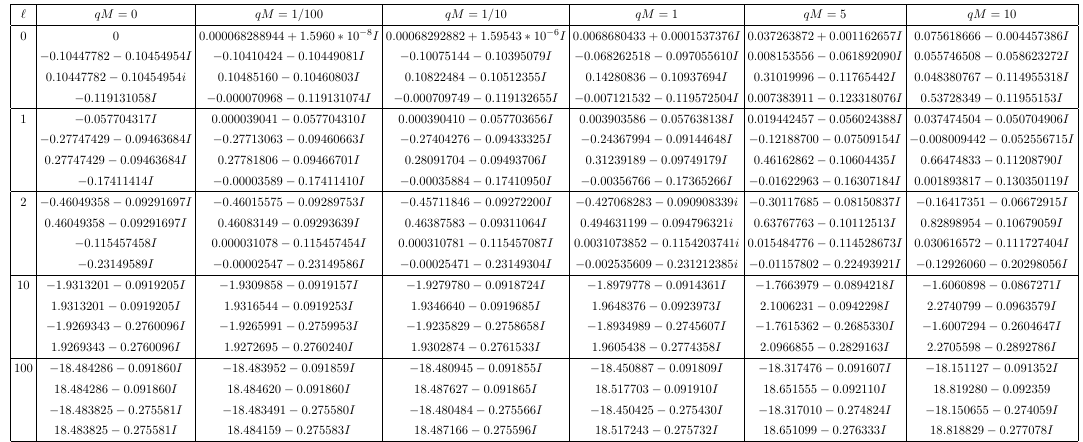
Figure 3 . The effective potential V eff M 2 as a function of r/M , for uncharged scalar fields with ‘ = 0 (left panel), ‘ = 1 (center panel), and ‘ = 100 (right panel) with Λ M 2 = 0 . 04 , and Q/M = 1 / 10 . Here r H /M ≈ 2 . 123 , and r Λ /M ≈ 7 . 399 .